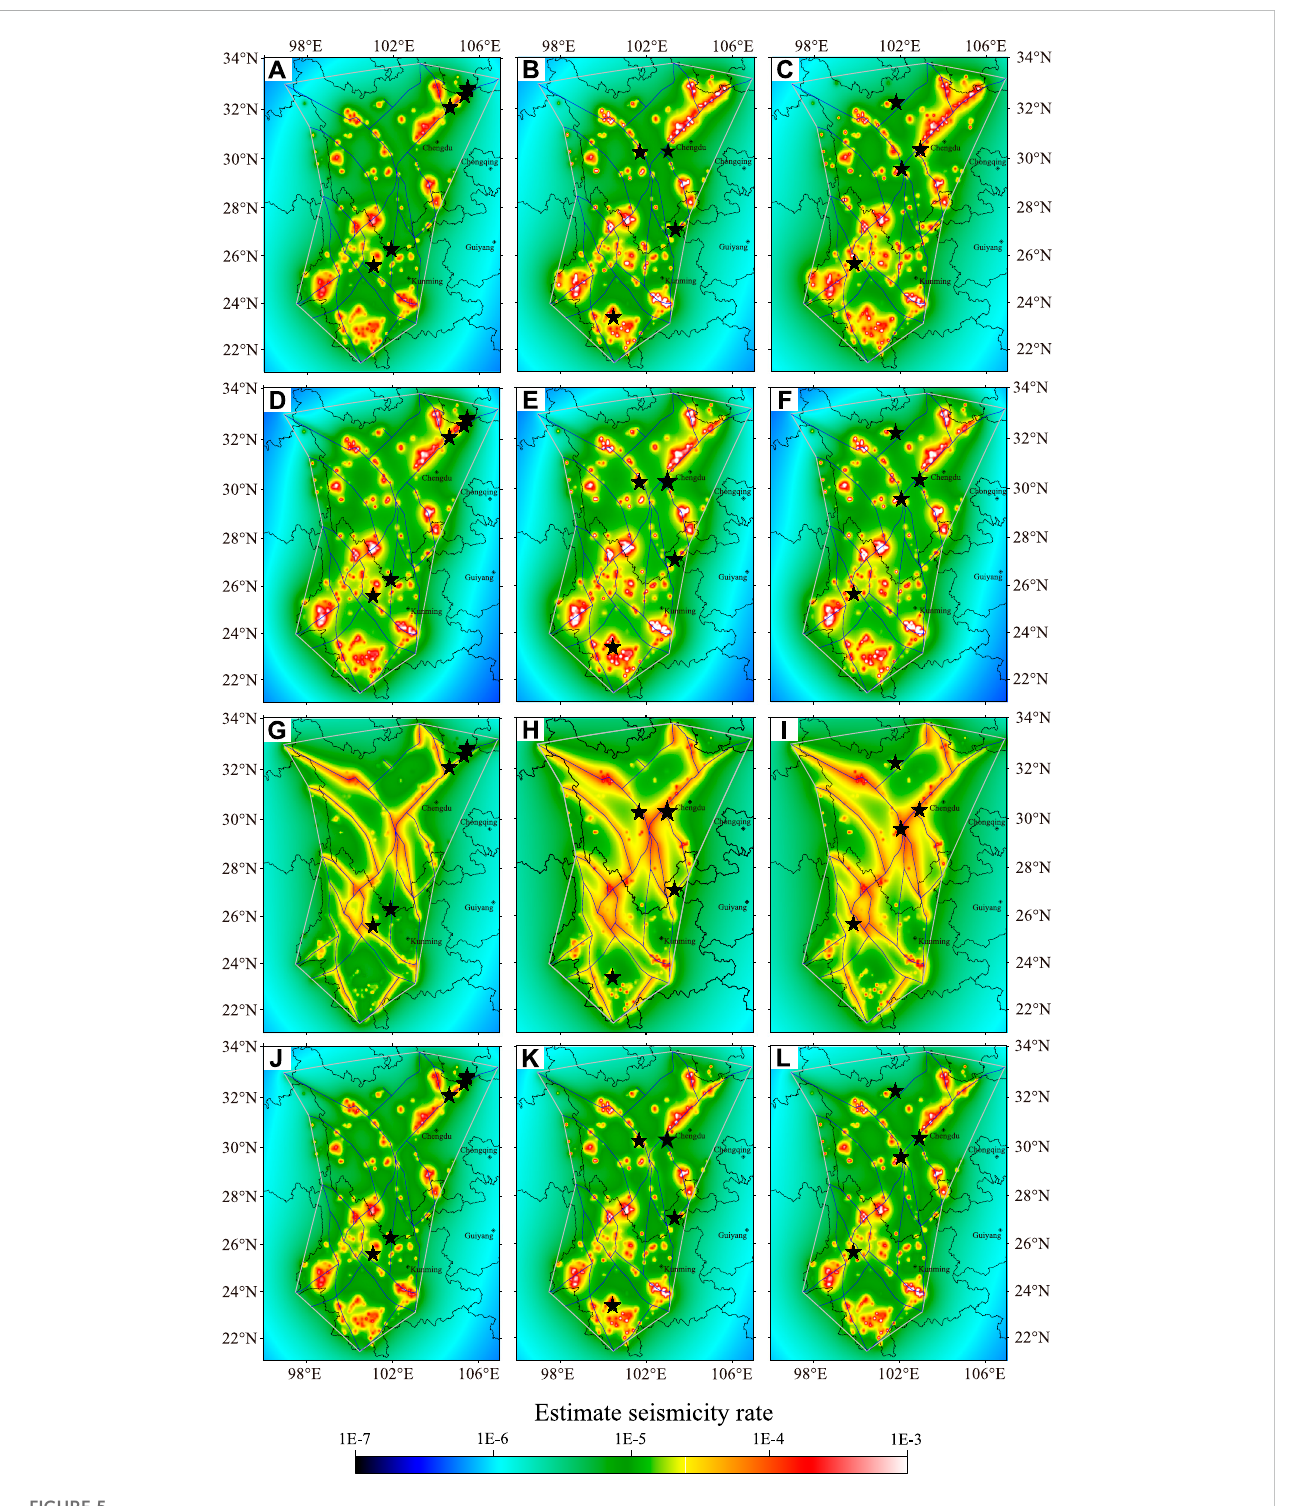
FIGURE 5 Estimated seismicity rate based on cataloged earthquakes and mapped faults, showing results for May 20, 2008 (left), January 1, 2013 (middle), and September10,2019(right ,L) . (A – C) Spatialvariationsinestimatedseismicityrates. (D – F) Seismicityratewith μ calculatedusingEq.4.Seismicityratewith μ set to (G – I) 0.9 and (J – L) 0.1. The black stars indicate the target